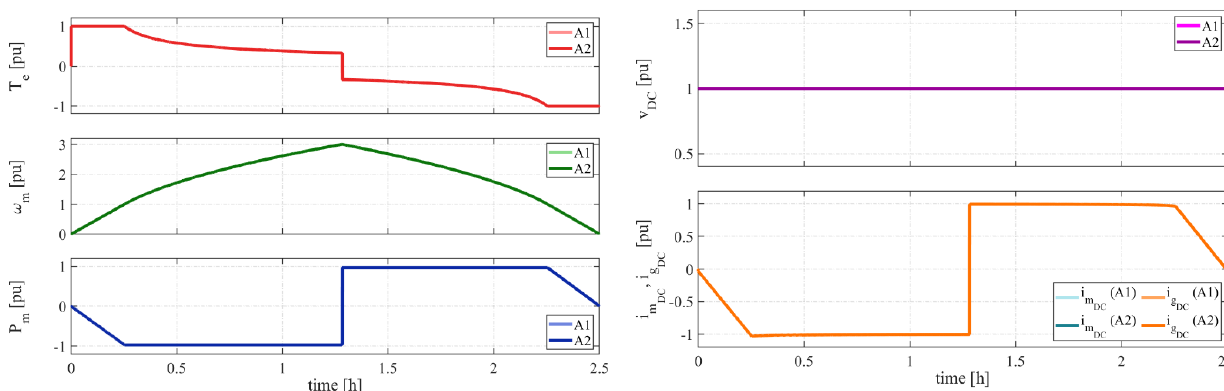
Figure 10. FESS torque ( T e ), speed ( ω m ), power ( P m ), DC-link voltage ( V DC ) and currents ( i g and i m ) achieved during round-trip tests (cases A1 and A2, quantities normalized to their corresponding rated values).